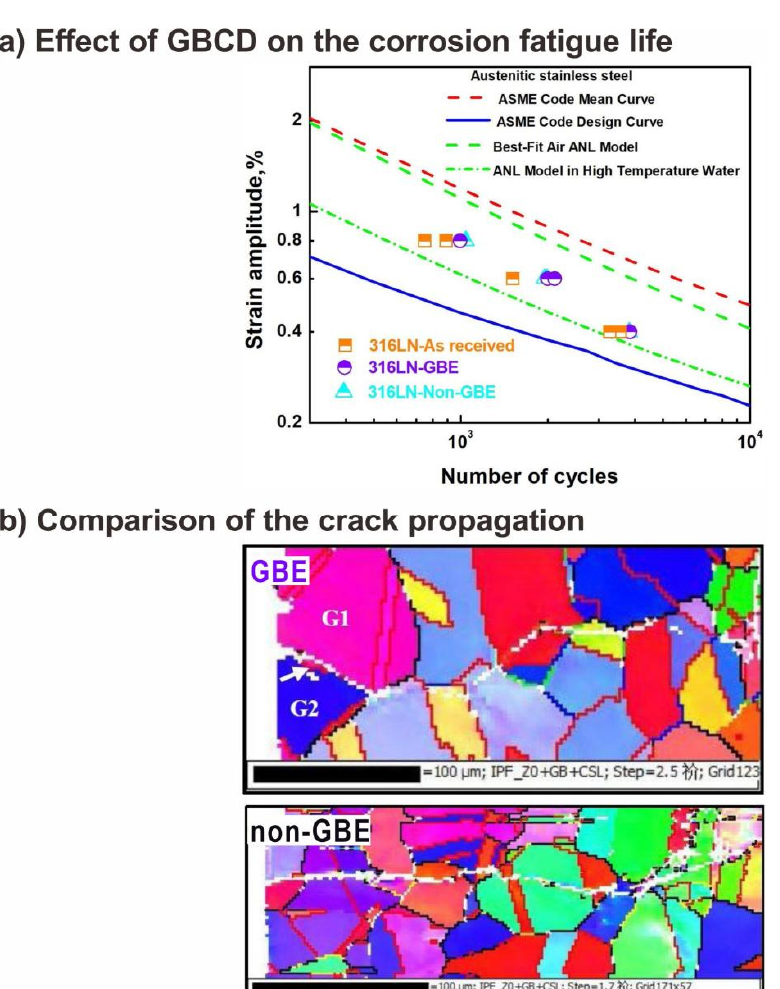
Figure 10. Effect of GBE on the fatigue performance of 316LN austenitic stainless steels in high- temperature salt solutions. ( a ) Relationship between strain amplitude and fatigue life for GBE and non-GBE samples; ( b ) Crack propagation in GBE and non-GBE samples. Adopted from Ref. [32]